Question: Identify the chart type used in this figure.
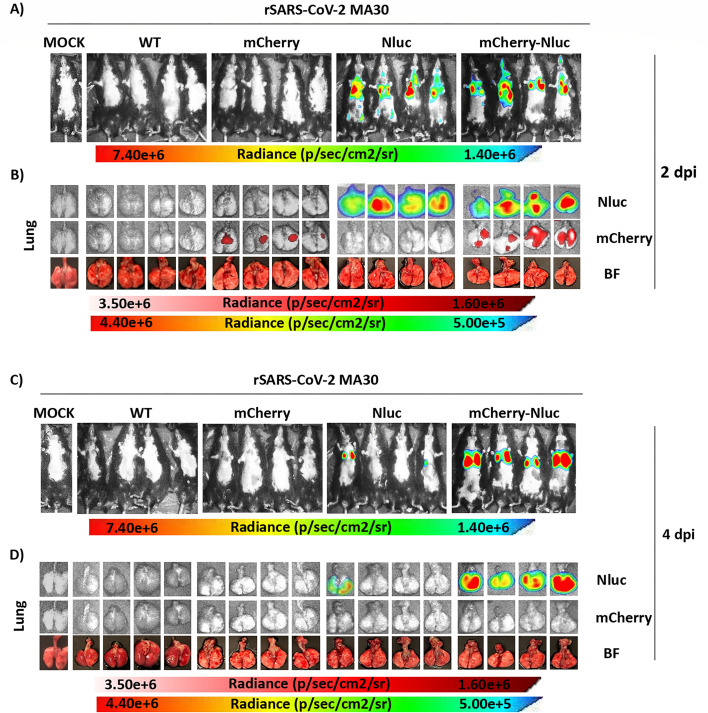
Answer: bar